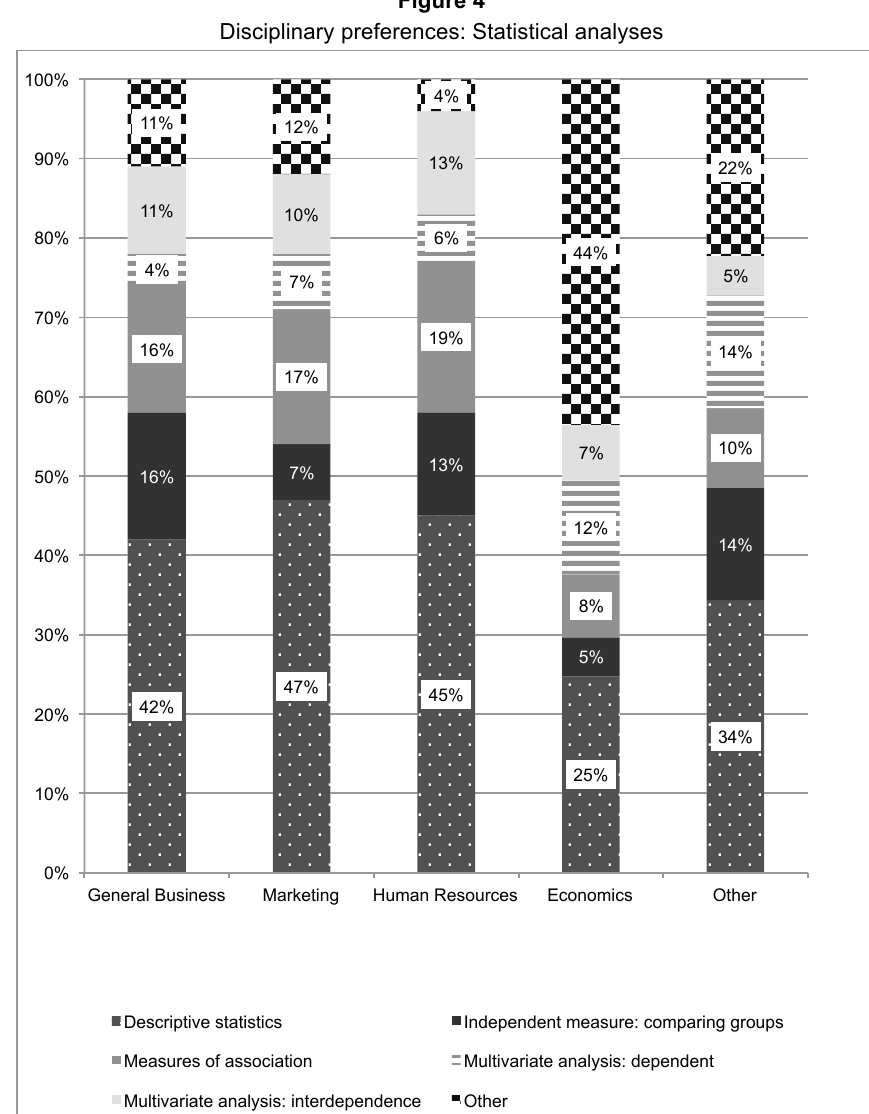
Disciplinary preferences: Statistical